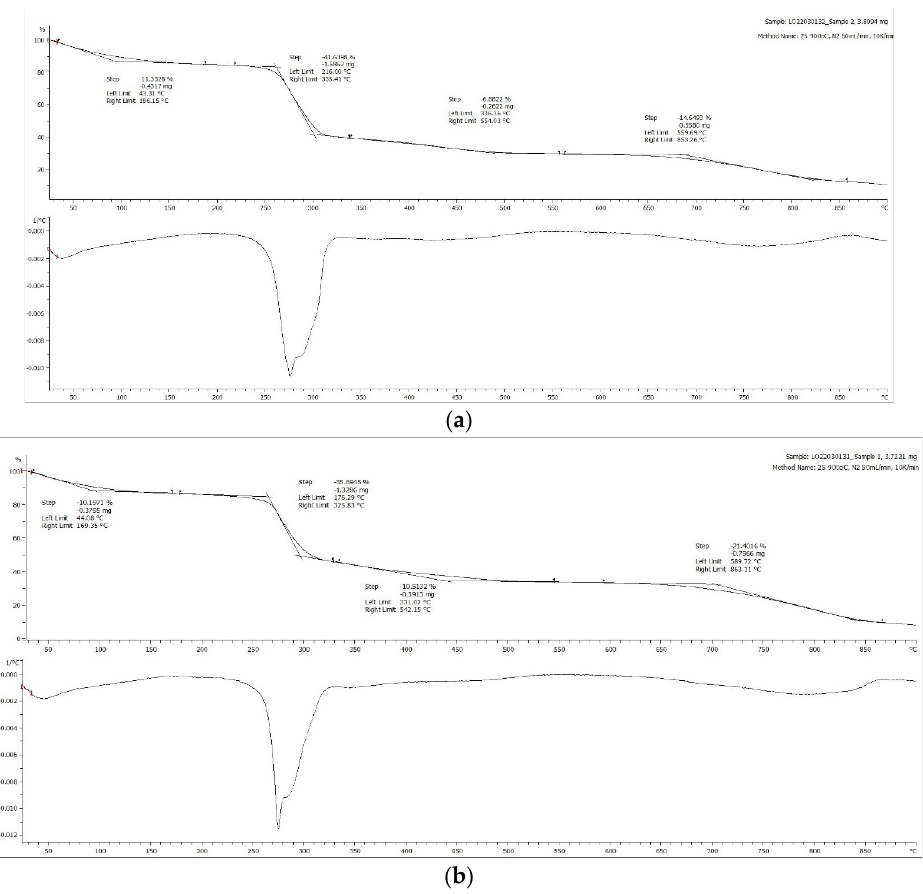
Figure 8 . TGA thermograms of ( a ) neat CMC film and ( b ) 1% lignin/CMC film. The top graphs show the mass loss, whilst the bottom graphs show the differential of the mass loss as a function of temperature.